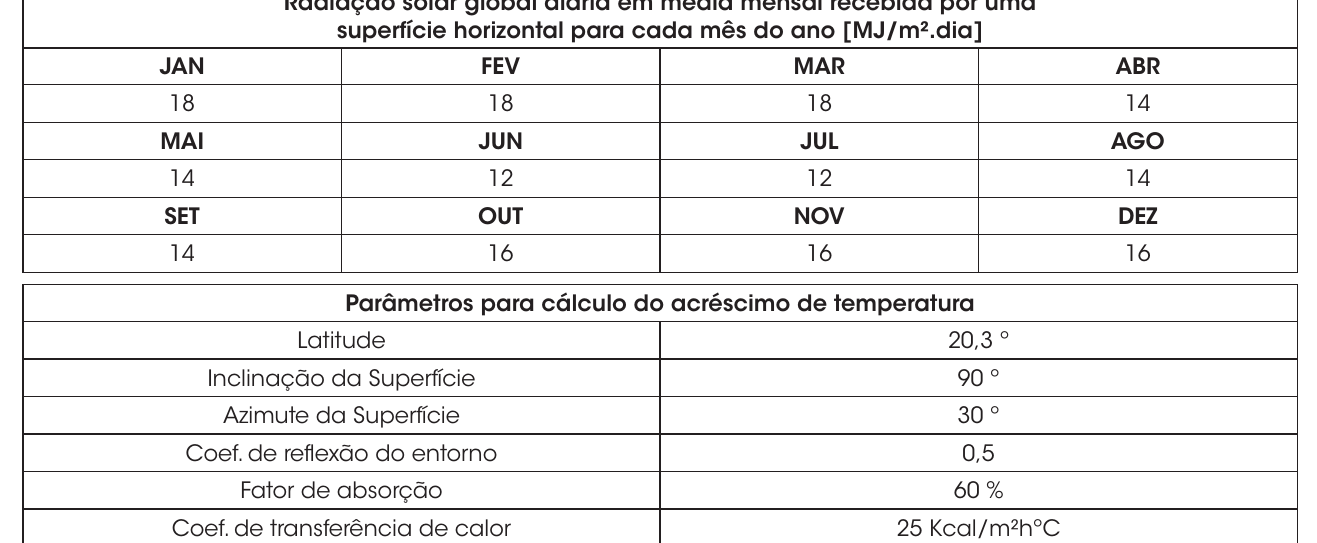
Aplicação do modelo: parâmetros de radiação solar – Vitória